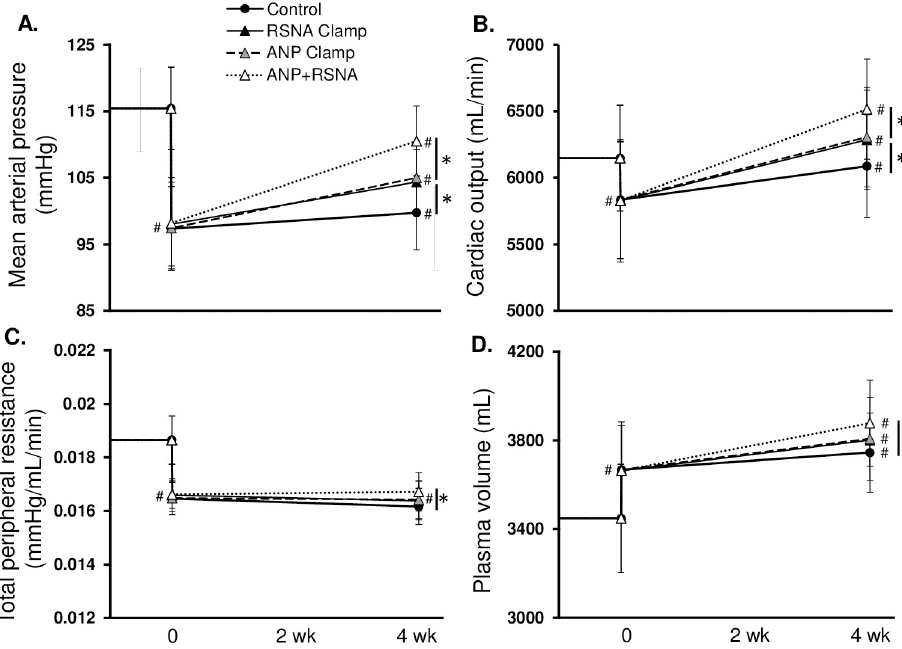
Fig 3. Cardiovascular responses to BAT among control (BAT Control), RSNA Clamp, ANP Clamp, and ANP +RSNA Clamp simulations. � p < 0.05; #p < 0.05 vs. baseline.